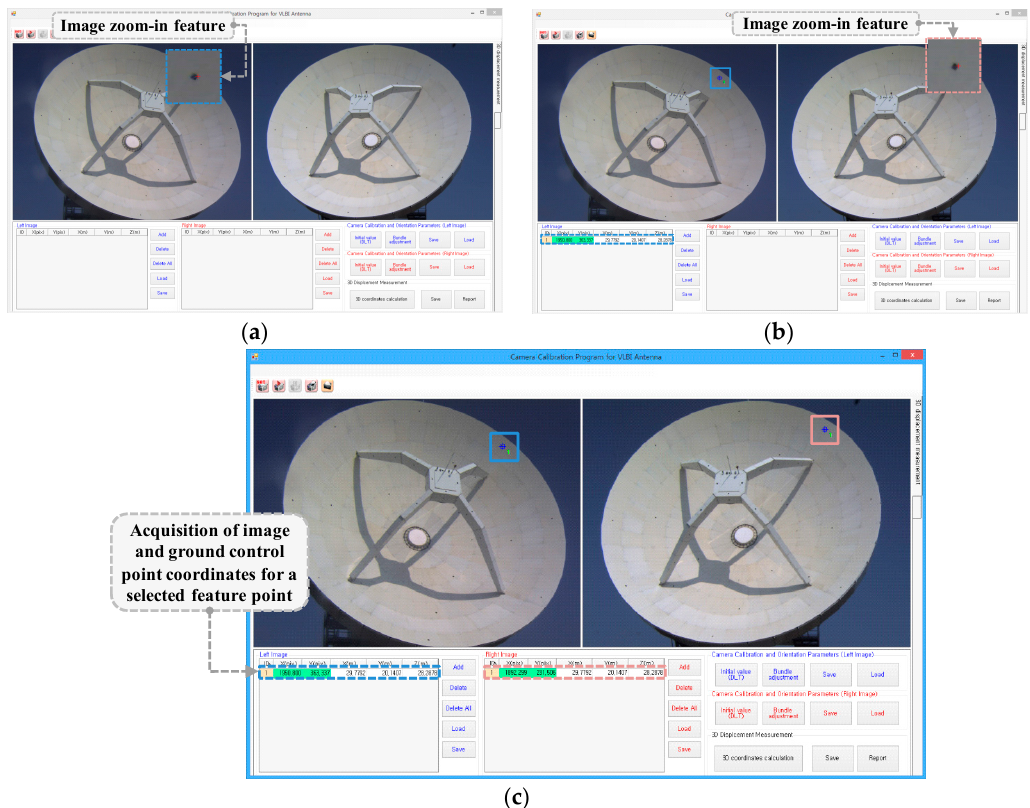
Figure 7. Acquisition of image and ground control point coordinates for the conjugate point in the stereo images using the developed program. ( a ) acquisition of the image coordinates for the conjugate point in the left image; ( b ) acquisition of the image coordinates for the conjugate point in the right image; ( c ) the image coordinates for the conjugate point in the stereo images.